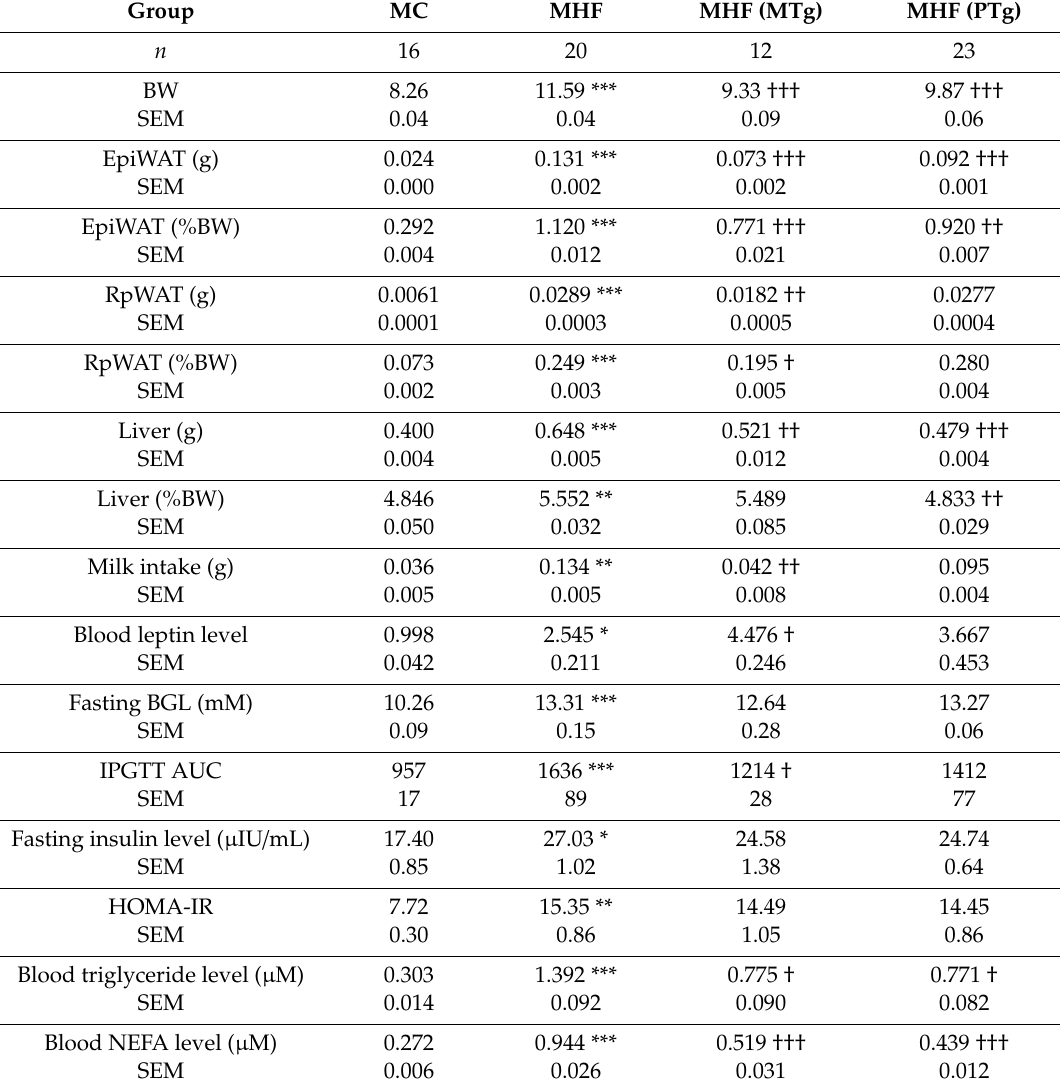
Table 1. Anthropometric and metabolic changes in the o ff